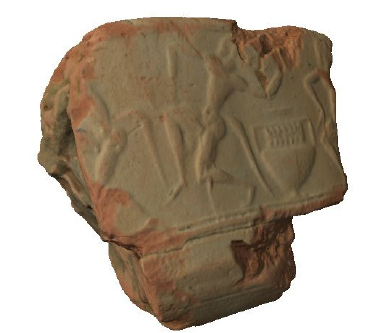
Figure 14. 3D model of the fragment with Komòs scene.